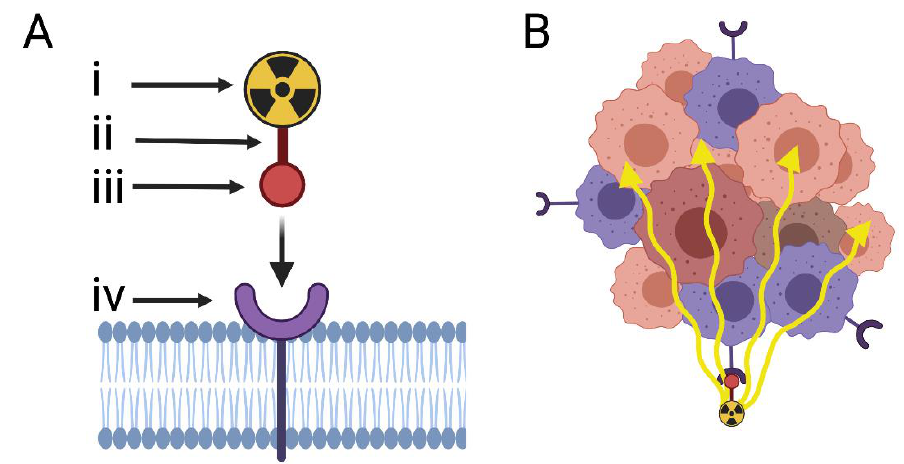
Figure 1. ( A ) Diagrammatic illustration of the two-step utility of a theranostic agent against a targeted cell-surface receptor. The theranostic agent is composed of a single targeting peptide (iii) that has affinity to the target receptor (iv) and is linked via a binding molecule (ii) to the diagnostic or therapeutic radionuclide (i). Diagnostic radionuclides are often positron emitting (e.g., Ga-68) and therapeutic radionuclides are often beta (e.g., Lu-177) or alpha emitting (e.g., Ac-225). For either radionuclide types, the targeting peptide remains the same. ( B ) The bystander effect. A therapeutic agent (alpha-/beta-emitting radionuclide conjugated to a receptor-seeking peptide) first binds to a cell surface tumour receptor, then creates a cytotoxic environment in which surrounding tumour cells that do not express the receptor (orange cells) are affected. Created with